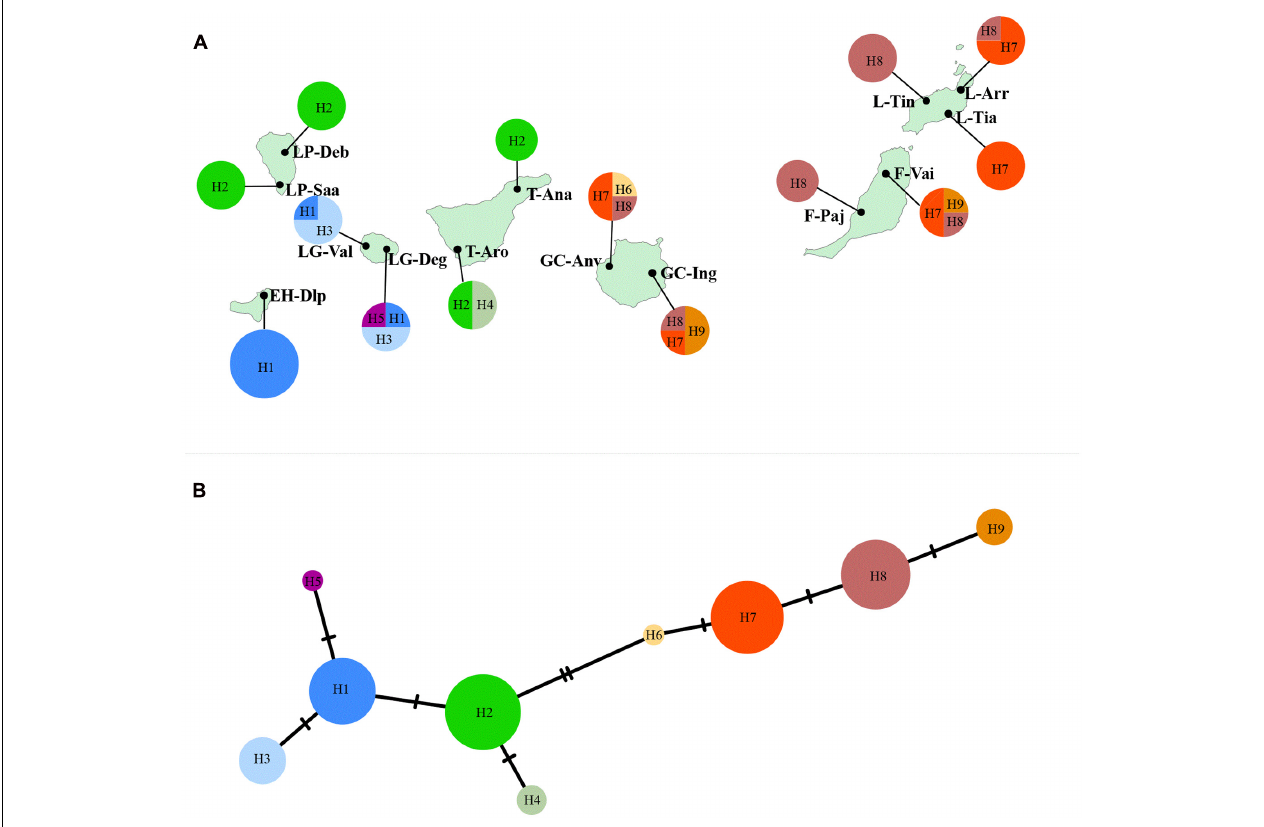
FIGURE 4 | (A) Distributions of chloroplast haplotypes in each sampled population. Population codes are same as that in Table 1 . (B) Haplotype relationships inferred with a TCS